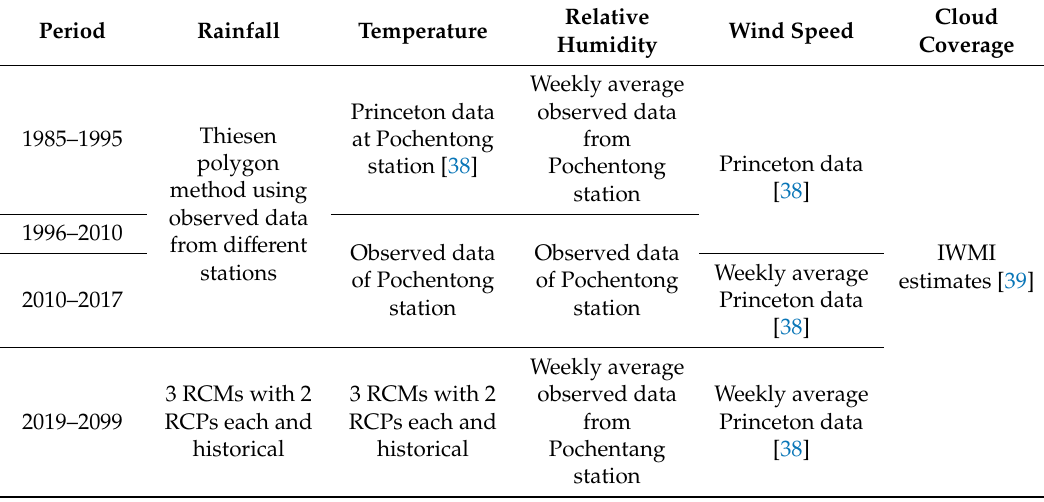
Table 2. Meteorological data source used as input to the Stung Chinit WEAP model.